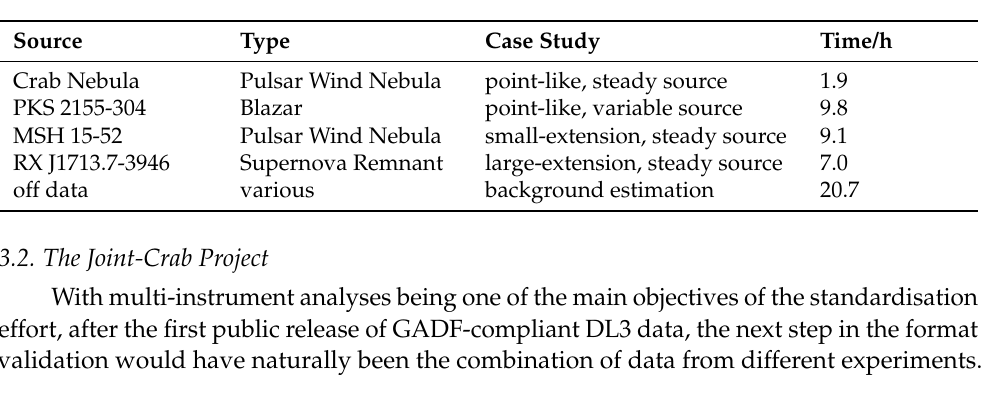
Table 1. Content of the H.E.S.S. Data Level 3 Data Release